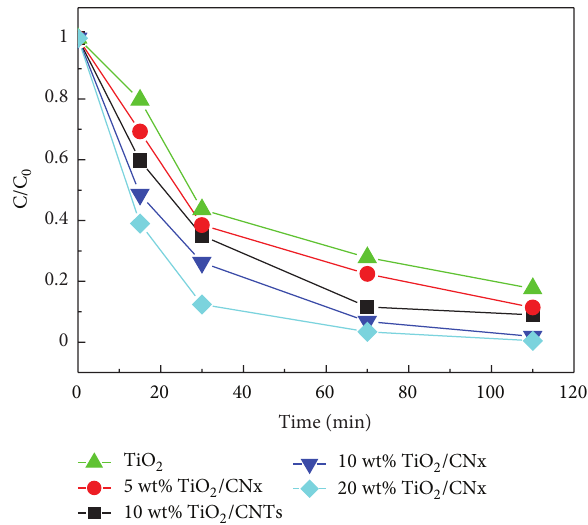
Figure 5: Comparison of photocatalytic activity between different photocatalysts.